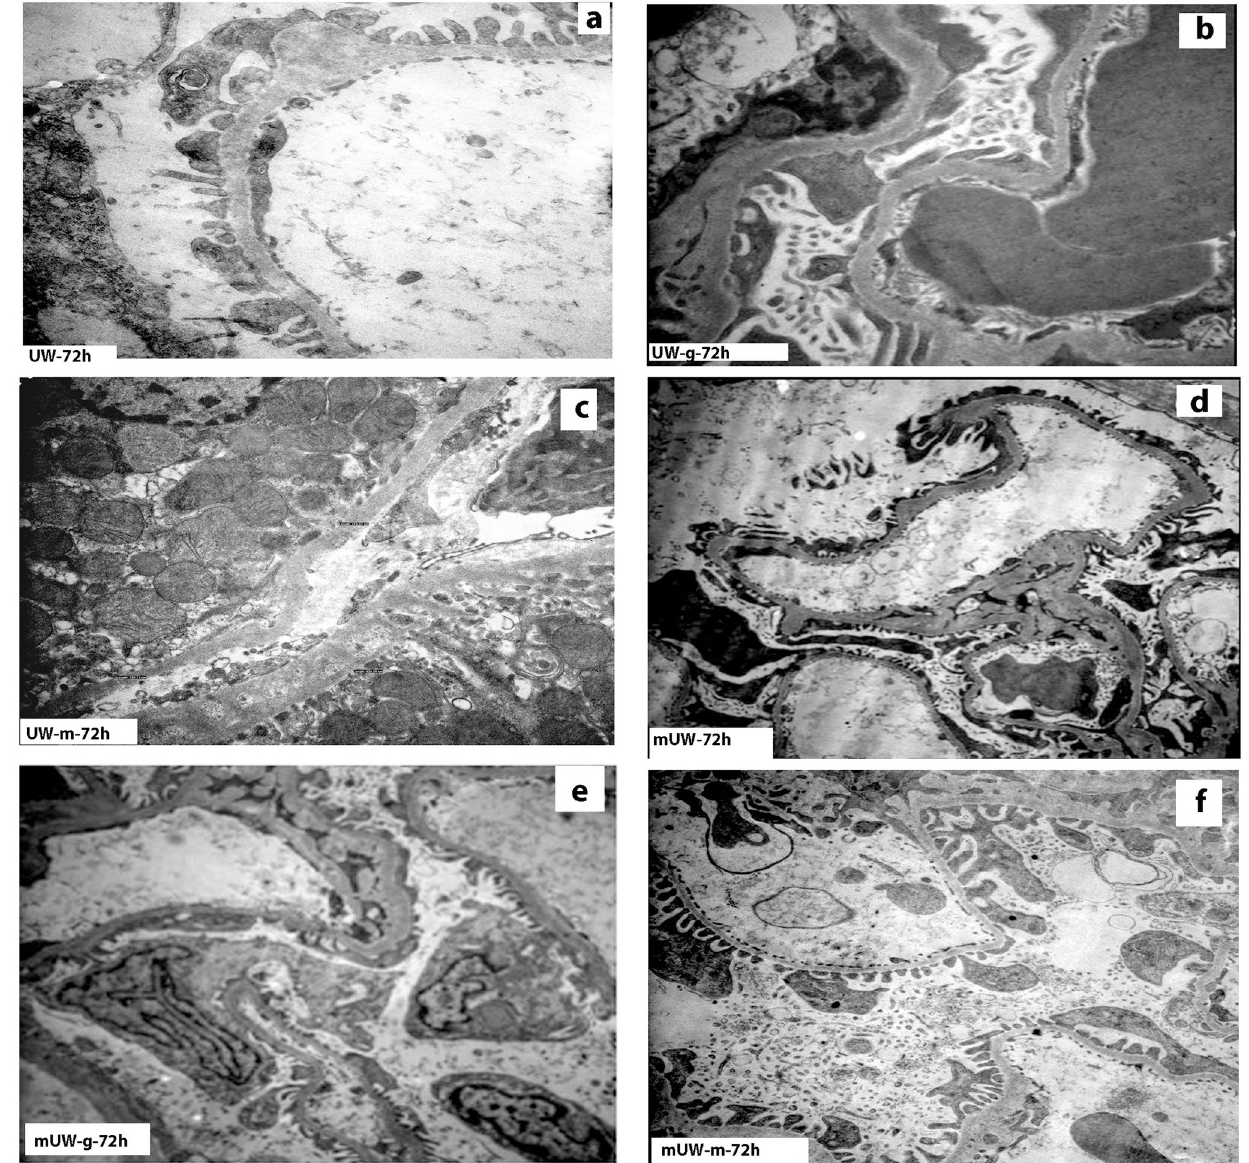
Fig 6. Electronmicrographs of kidney tissue in all experimental solution groups. Kidney tissue damage was ultrastructurally characterized by effacement of pedicels in podocytes, thickening of glomerular basal laminae in UW (A) group. Degenerated podocytes and disturbed glomerular basal membranes were observed in UW-g solution group (B) . Mildly degenerated podocytes were reflecting low degree of glomerular injury in UW-m group (C) . Minimal proximal tubular degenerations were also noticed in this group. Mild degree of podocytes degeneration and moderately thickened glomerular basal laminae in mUW (D) and mUW-g (E) groups. Mild podocytes degeneration and thickening of glomerular basal laminae in mUW-m (F) group. (original magnifications; UW group; x20.000, UW-g group; x20,000, UW-m group; x5000, mUW; x7,500, mUW-g; x7,500, mUW-m;